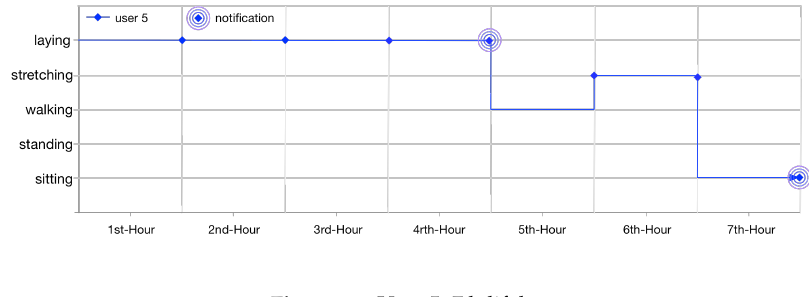
Figure 16. User 5, 7 h